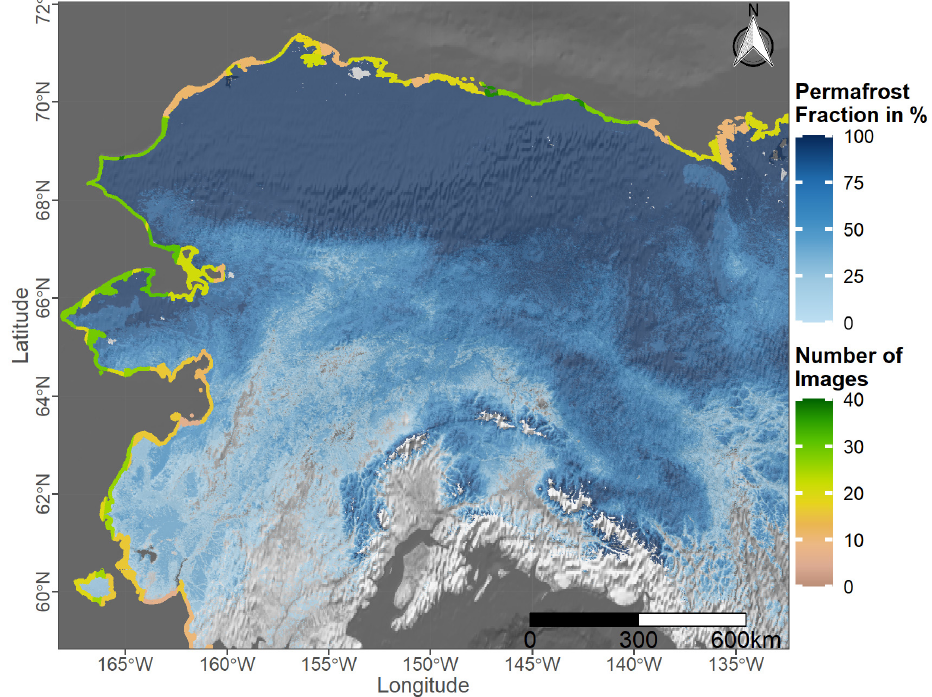
Figure 8. Number of available Sentinel-1 (S1) Ground Range Detected (GRD) scenes in Interferometric Wide (IW) swath mode over Alaska within June–September 2020 as a quality layer for generating the Deep Learning (DL) coastline product for the year